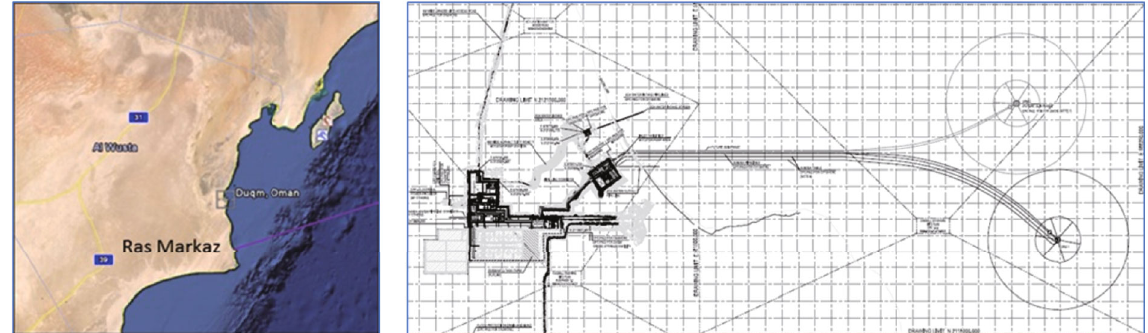
Figure 2: Location of Ras Markaz Crude Oil